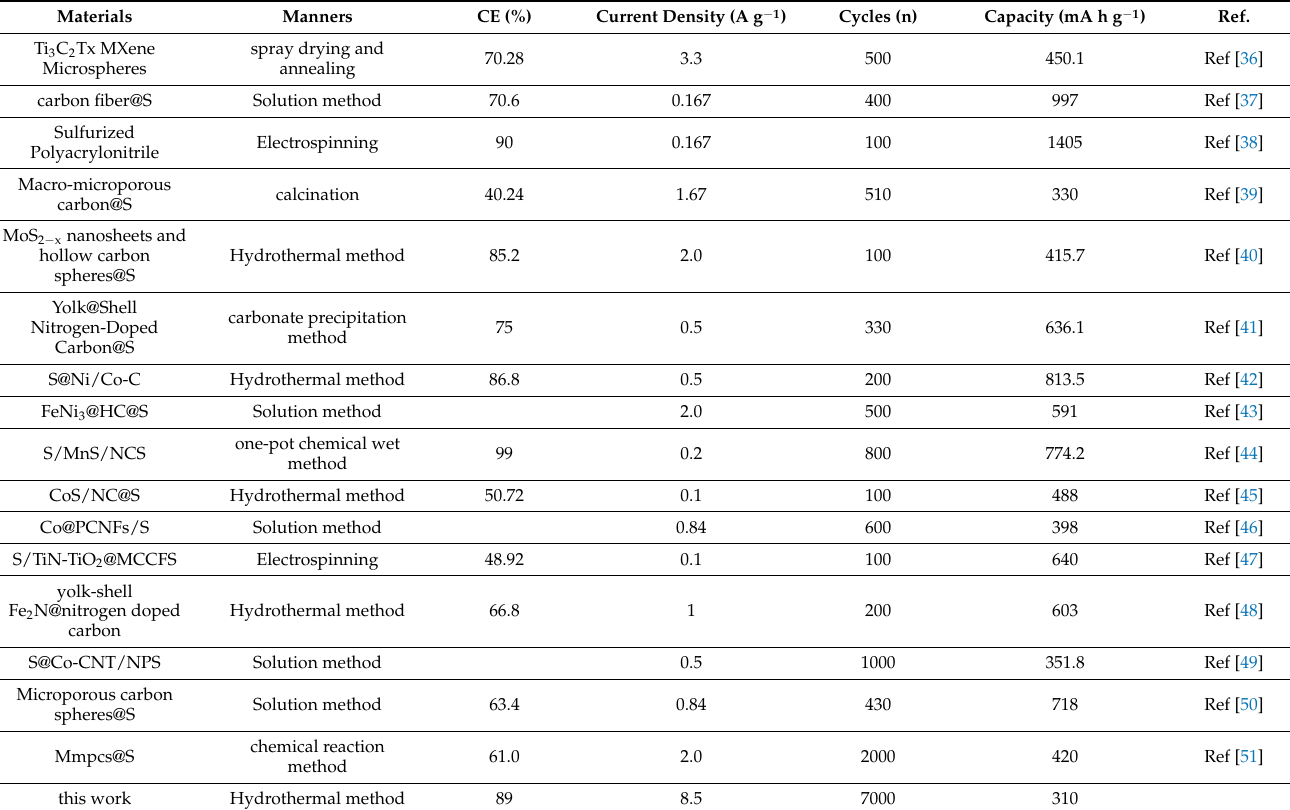
Table 1. The electrochemical properties for the previous